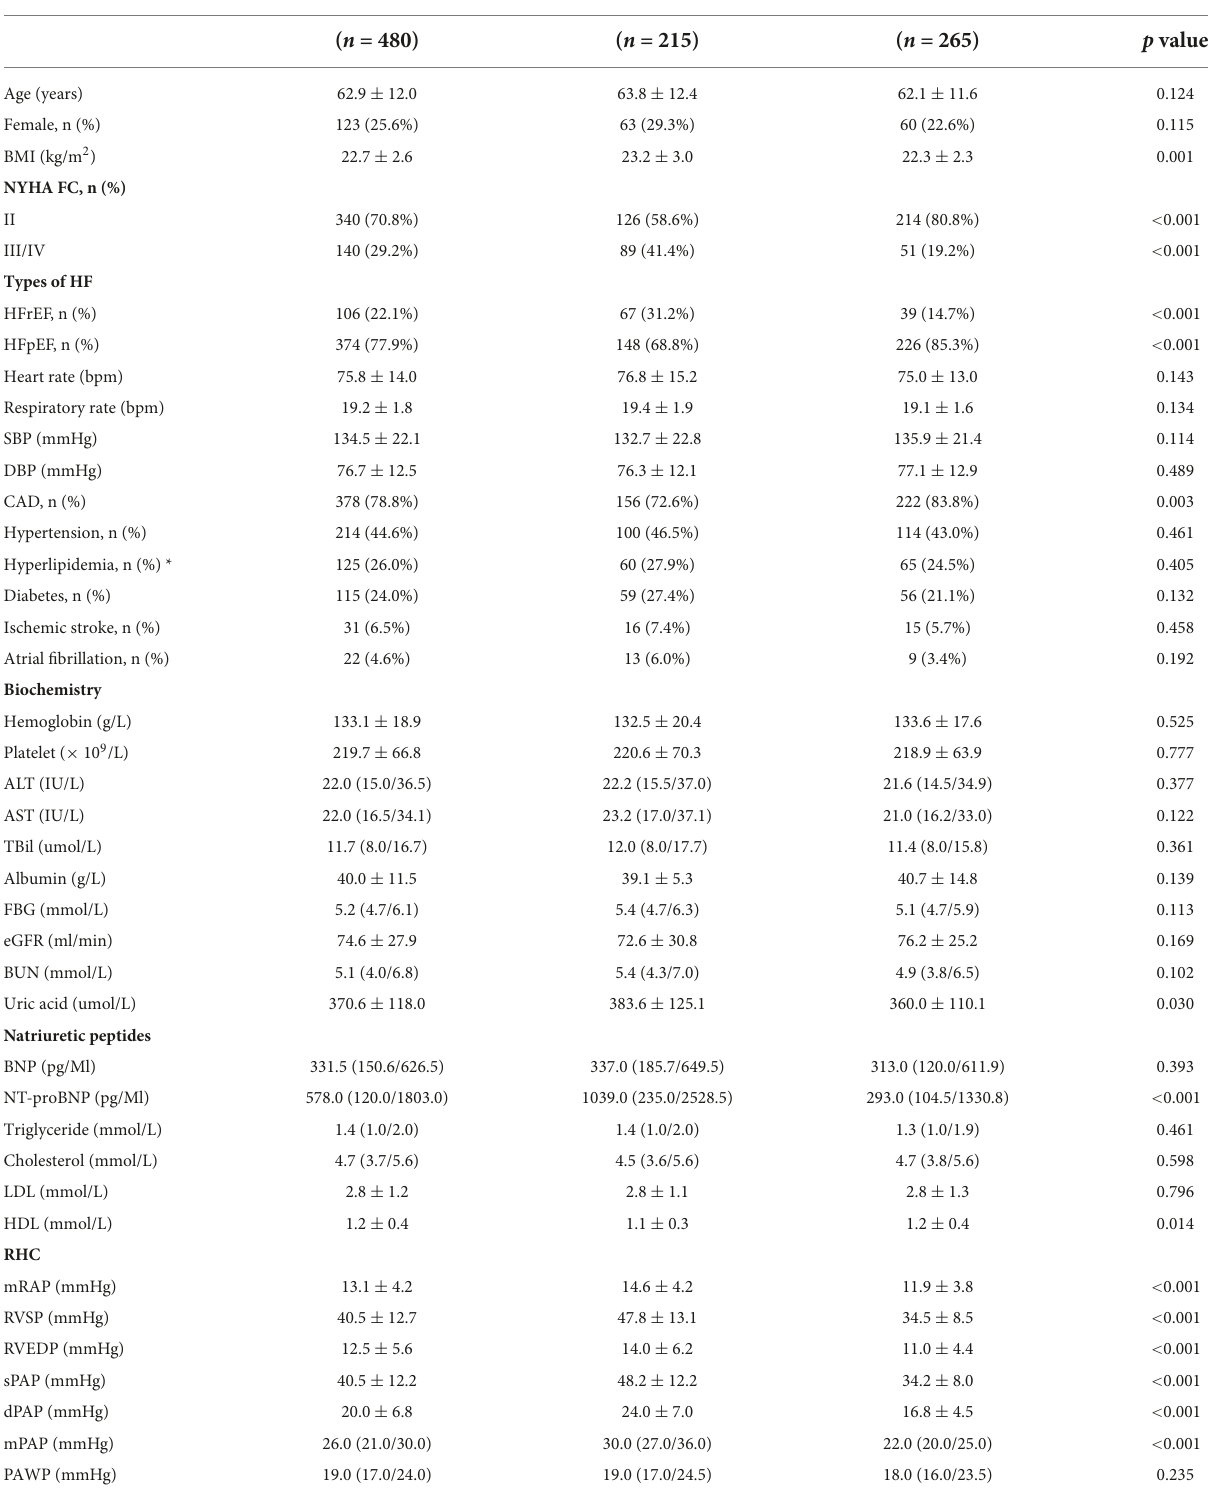
TABLE 1 Baseline demographic, clinical and hemodynamic characteristics of all patients enrolled, patients with PH-LHF, and non-PH-LHF. Overall